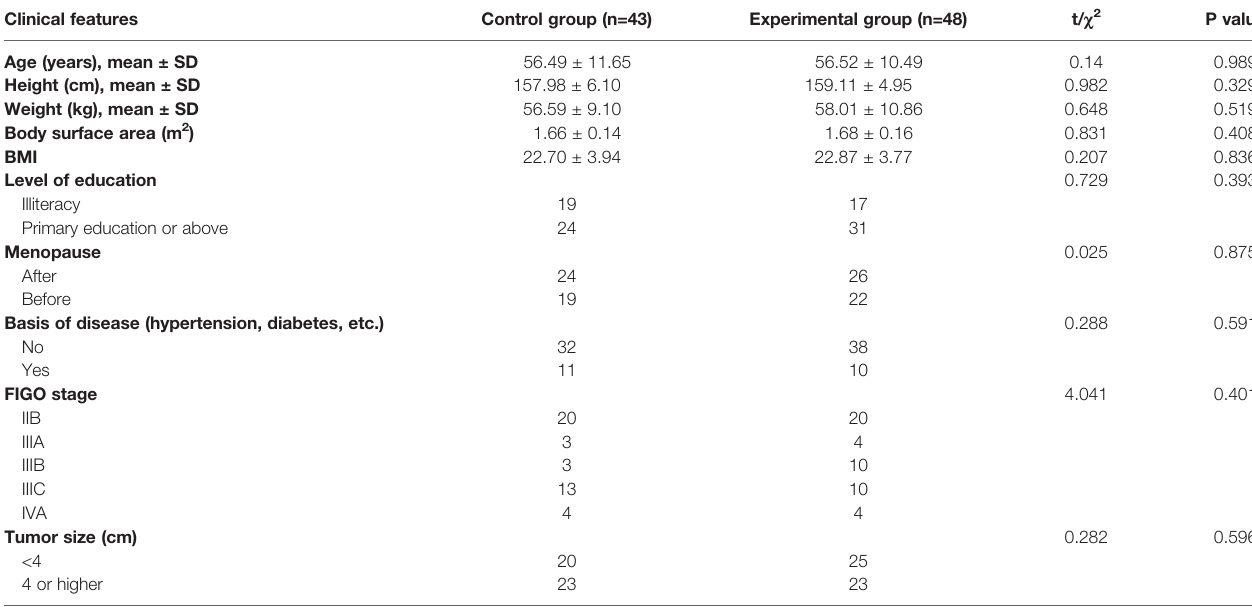
TABLE 1 | Comparison of baseline characteristics between the two groups. Clinical